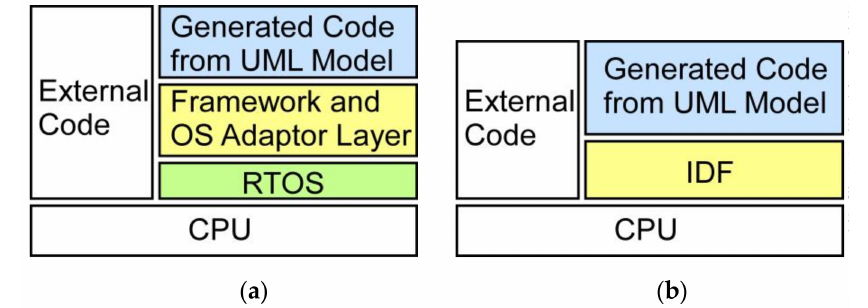
Figure 3. Software structure: ( a ) With an operating system; ( b ) Without an operating